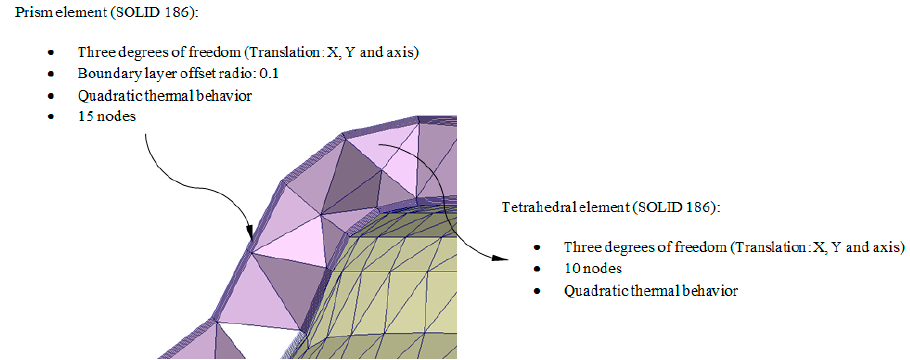
Figure 4. Detail of the three-dimensional elements and boundary layers that make up the mesh for